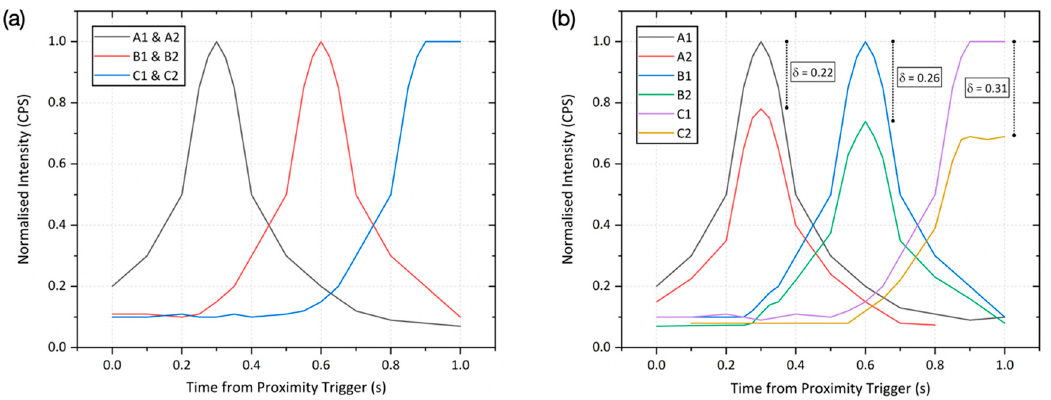
Figure 7. Geiger–Muller (GM) detector responses to a 5 µSv/h Cs-137 source transiting through the Gatekeeper system: ( a ) “unshielded” and ( b ) “shielded” through being located on the left hand side of the user.